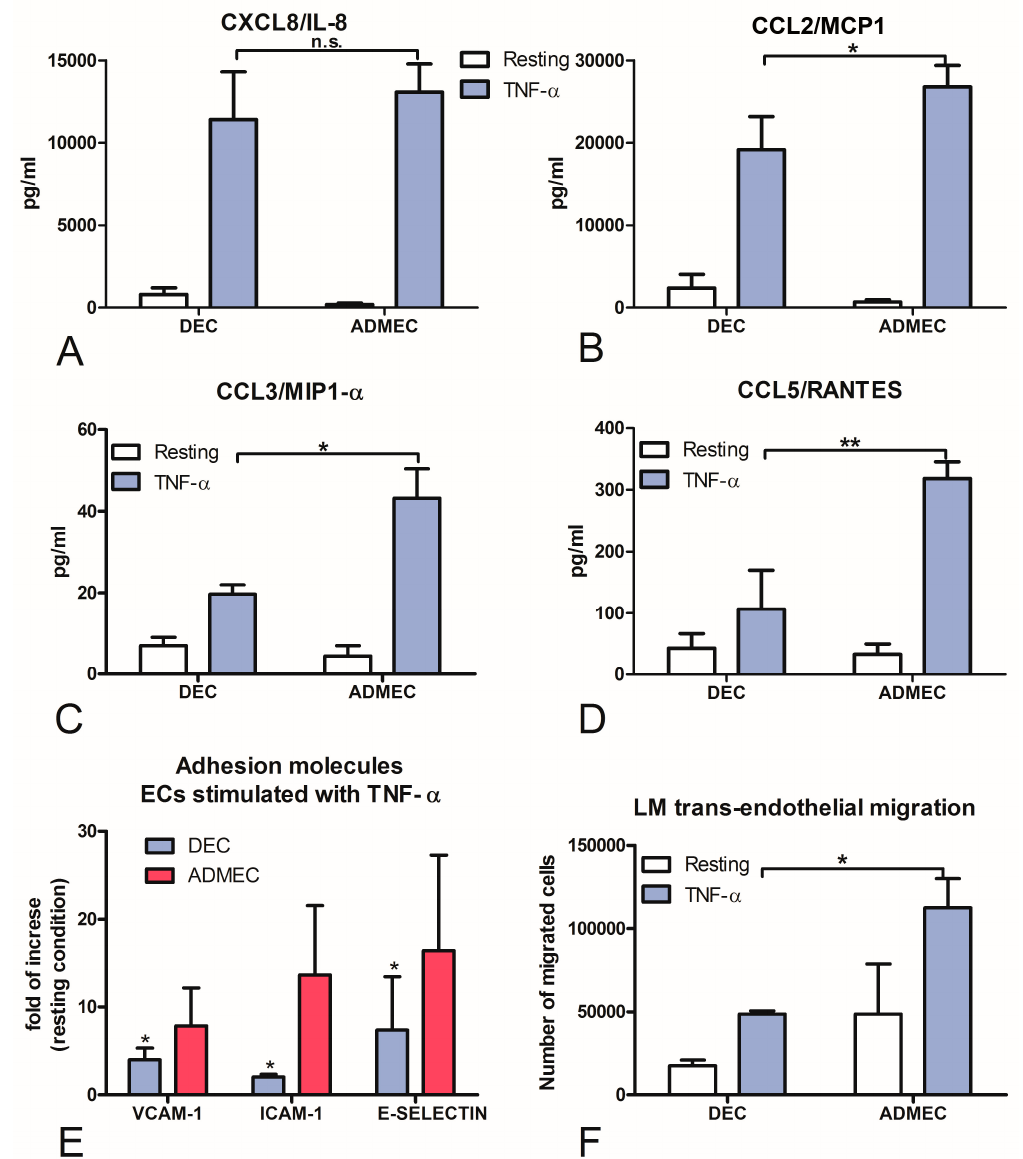
Figure 4. Secretion of chemokines and surface-expression of adhesion molecules by ECs stimulated with TNF- α . CXCL8/IL-8 ( A ), CCL2/MCP-1 ( B ), CCL3/MIP-1 α ( C ) and CCL5/RANTES ( D ) production